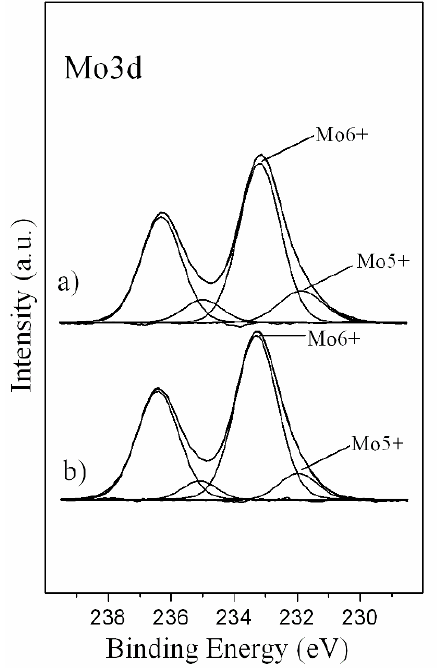
Figure 5. Binding energy of Mo3d peaks of: a) ZrMo